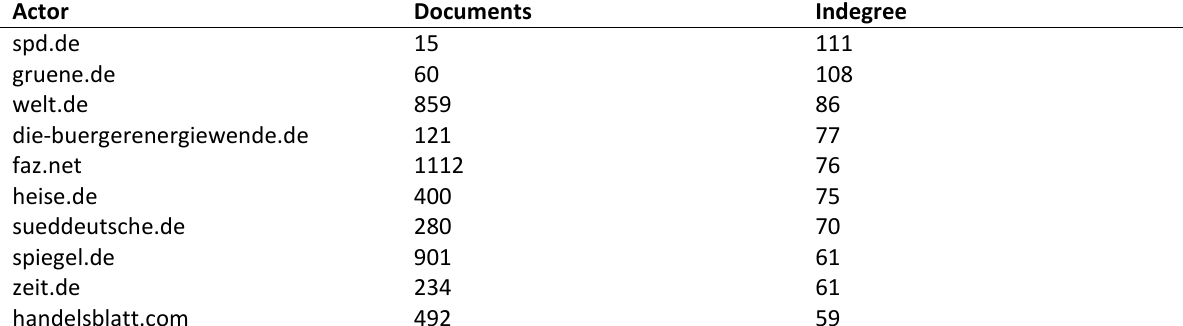
Table 2. Actor productivity (by documents published) and indegree.